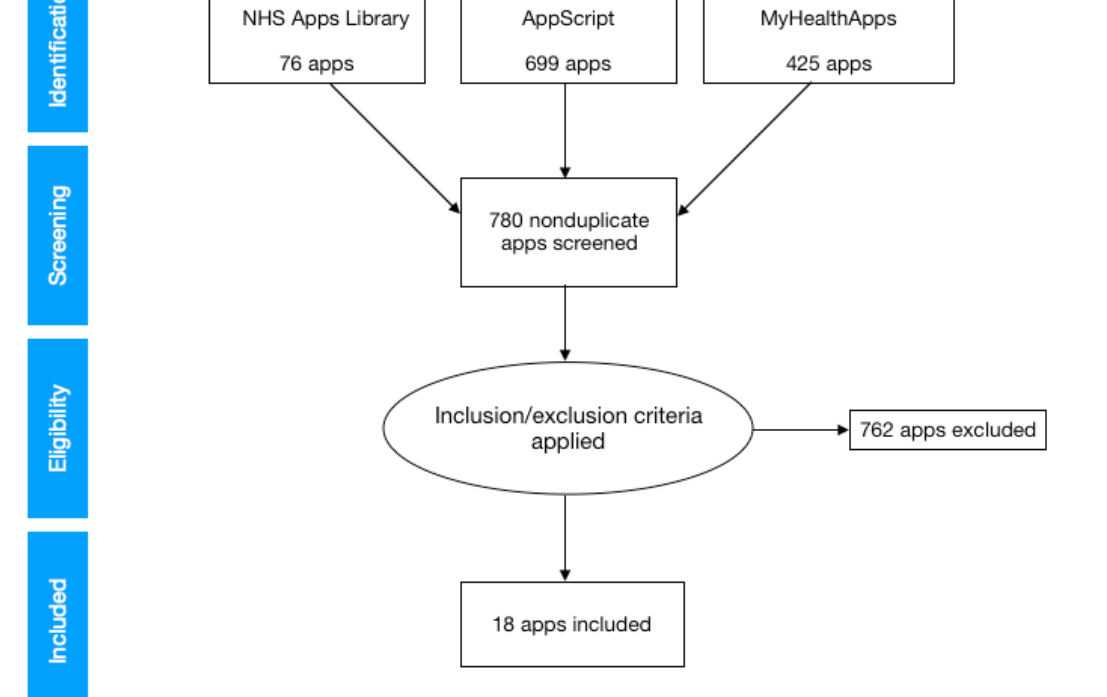
Figure 1. Preferred Reporting Items for Systematic Reviews and Meta-Analyses diagram for